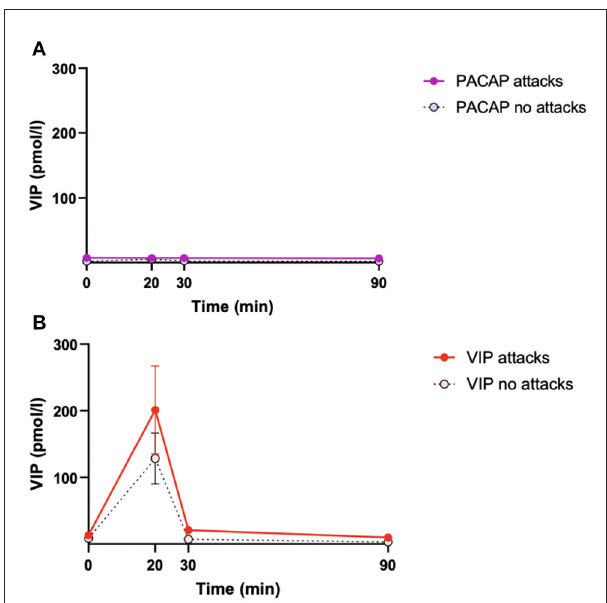
FIGURE4 Mean plasma levels of VIP in patients reporting cluster headache and attack-free patients during PACAP days (A) and VIP days (B) . We included eCHA and cCH patients. The solid lines with red/purple dots represent the average of individuals who reported cluster headache. The dashed black lines with white dots represent the average of individuals who did not develop cluster headache. Error bars are the standard errors of the mean.